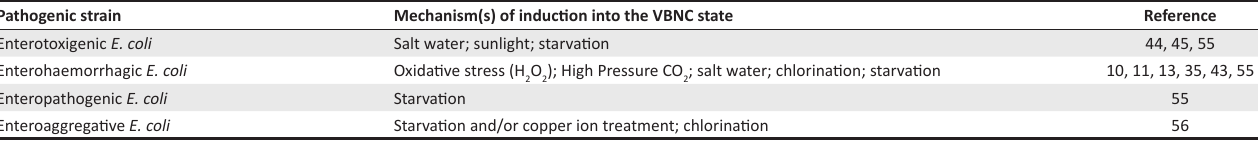
TABLE 5: Pathogenic Escherichia coli known to enter the viable but non-culturable state. Pathogenic